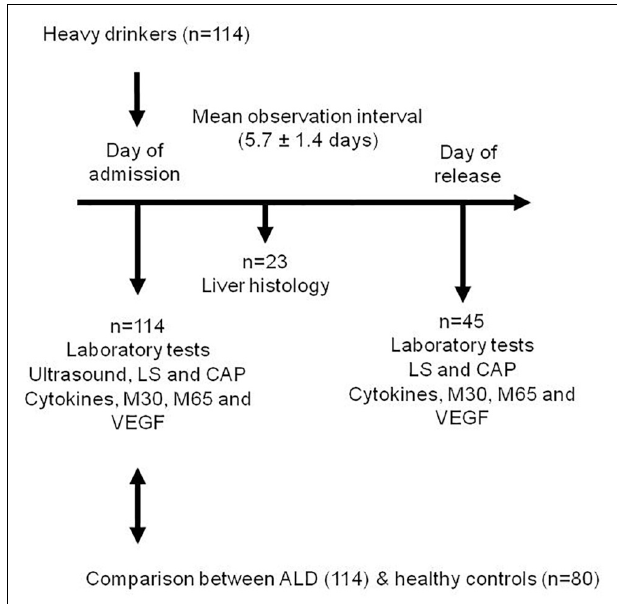
FIGURE 1 | Study design.